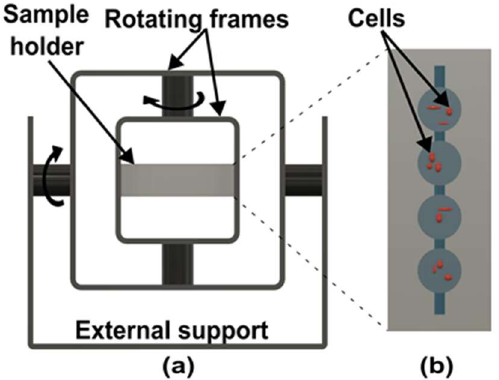
Figure 5. Schematic of random position machine. ( a ) Design of random position machine with two rotational axes. (Adapted with permission from [20]. Copyright 2020, Authors) ( b ) Top view of microgravity on-chip to research brain cancer cells. (Adapted with permission from [72], Copyright 2022, Authors).